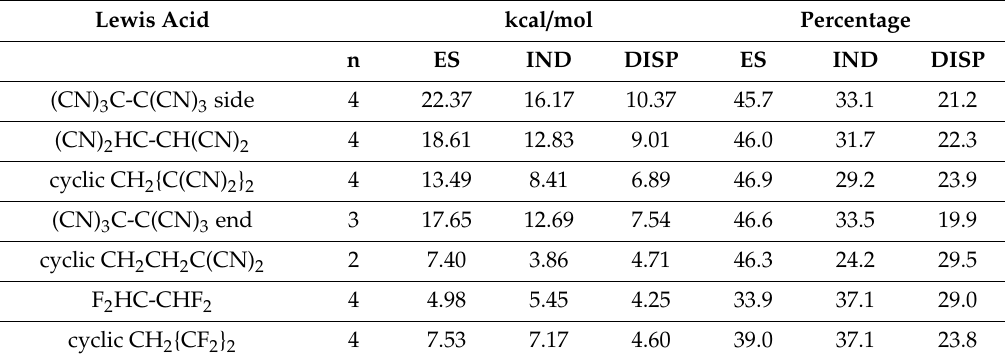
Table 5. Symmetry-adapted perturbation theory (SAPT) partitioning of the interaction energies in complexes with NH 3 , along with their percentage contribution to the total of all three attractive terms. ES: electrostatic, IND: induction, and DISP: dispersion. Lewis Acid kcal / mol Percentage